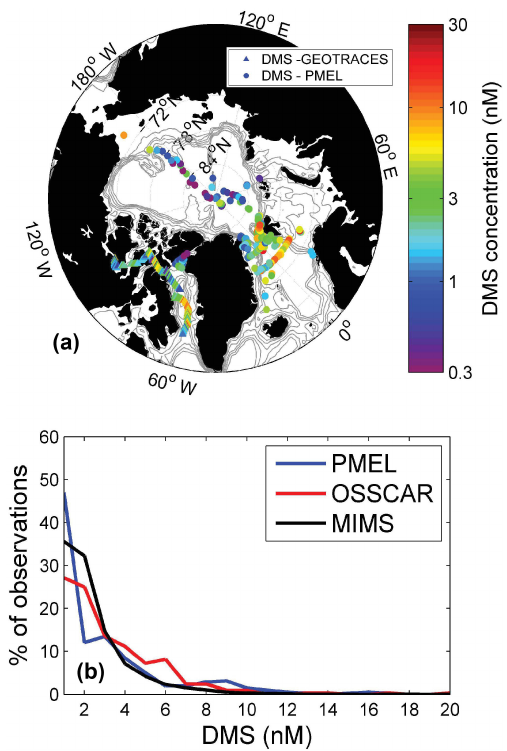
Figure 6. Comparison of OSSCAR- and MIMS-measured DMS from this study with existing summertime data in the PMEL database. Panel (a) shows the geographic distribution of DMS mea- surements in the PMEL database and those obtained by this study (using OSSCAR), while panel (b) shows a histogram of DMS concentrations in three datasets – the MIMS dataset (33250 data points), the OSSCAR dataset (344 points) and the PMEL dataset (415